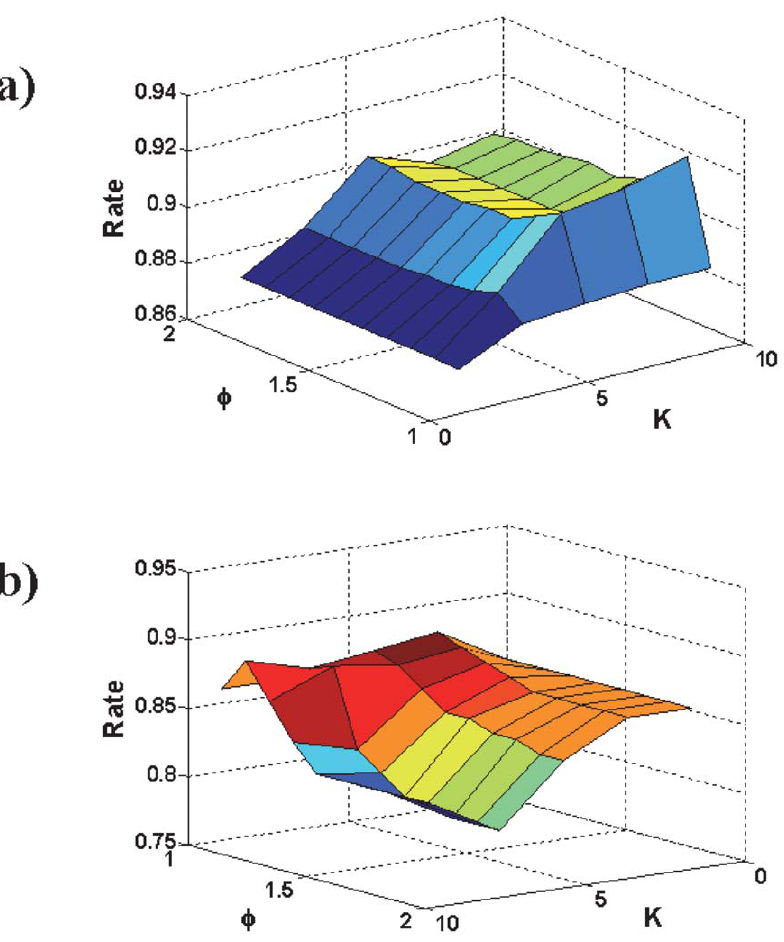
Figure 3. 3D graph to show the jackknife success rates with the different parameters. (a) The results obtained by the 1st level prediction, and (b) the results obtained by the 2nd level prediction, where the parameters and are defined in Eq.16.